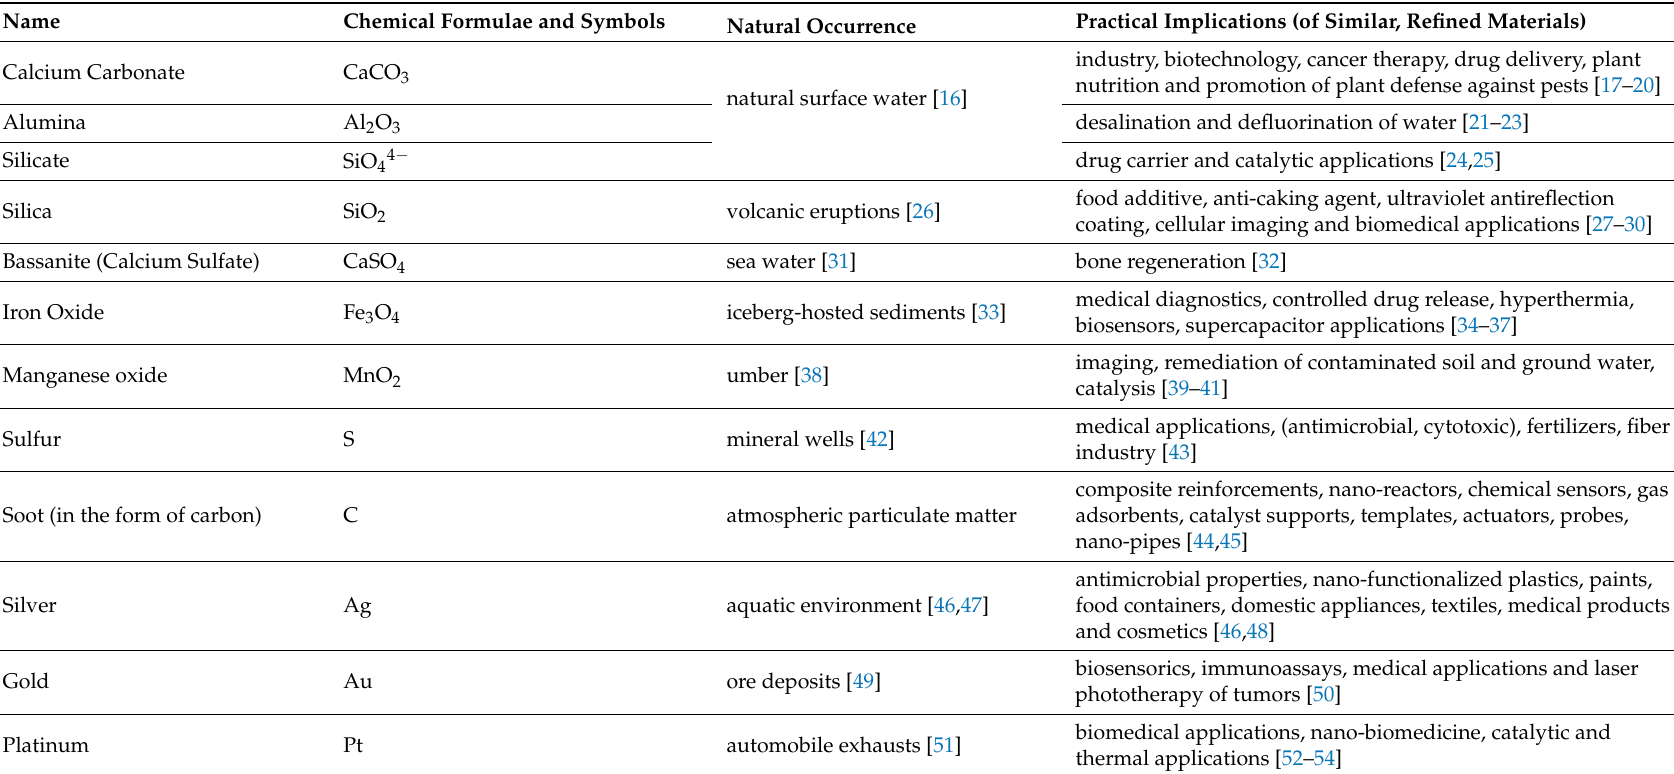
Table 1. Selected examples of naturally occurring inorganic micro- and nanoparticles frequently found in our environment and associated with certain possible applications or biological implications. Please note that the practical applications mentioned usually rely on refined materials of particularly good particle quality and purity and not, or not yet, on the crude naturally occurring materials of similar constitution and